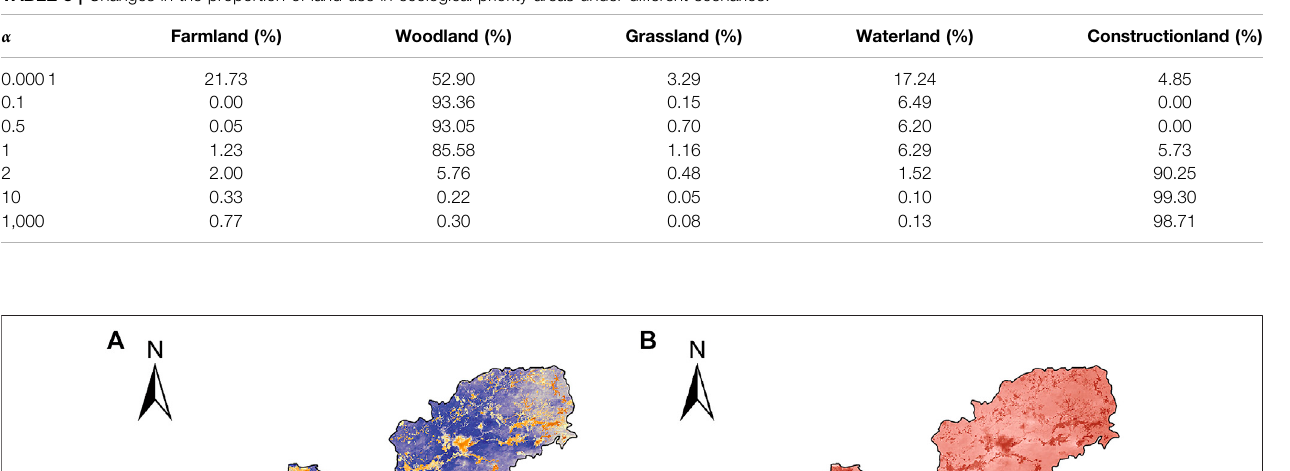
Frontiers in Environmental Science |